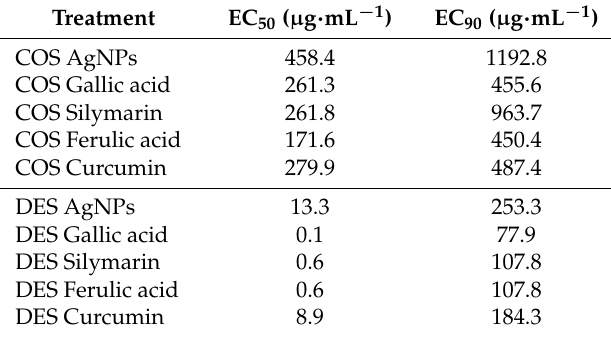
Table 1. Effective concentrations that inhibited mycelial growth by 50% and 90% (EC 50 and EC 90 ,